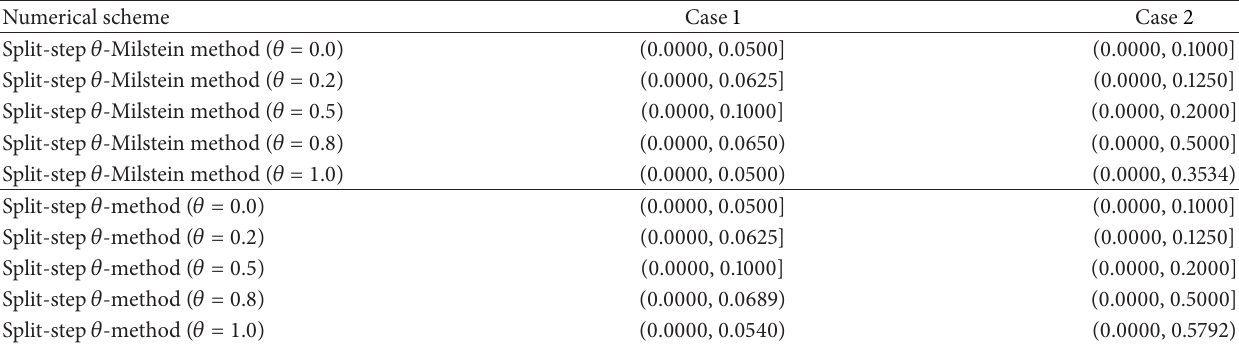
Figure 1: Errors versus step-sizes for the SDHNNs (43). Table 1: Calculated intervals of step-size for mean-square stability of the numerical